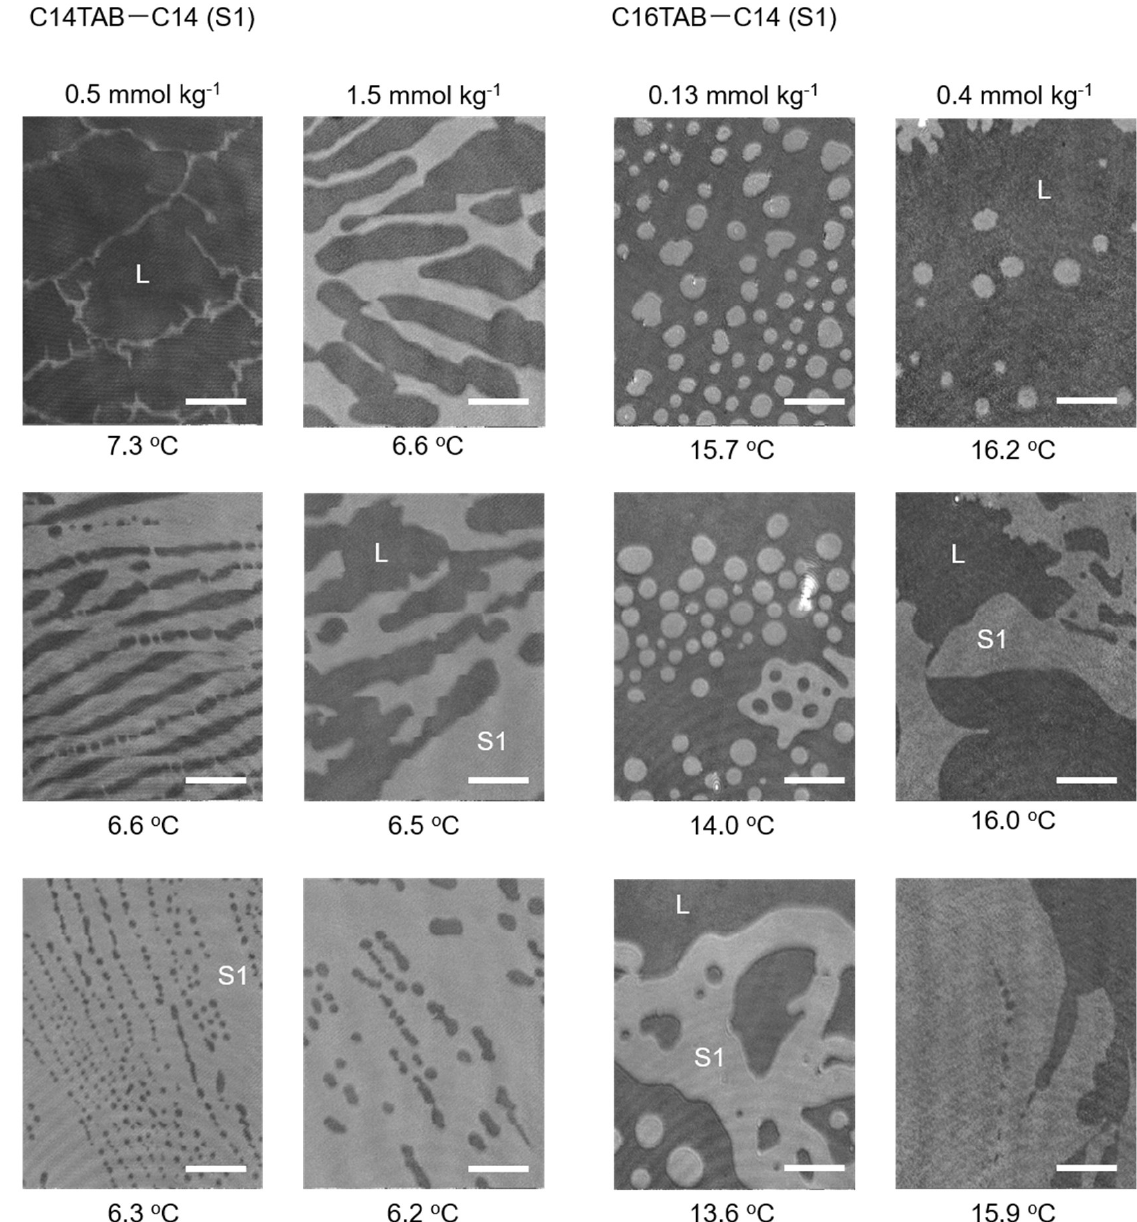
Figure 3. BAM images of nucleated S1 domains for the C14TAB − C14 system (left two columns) and those for the C16TAB − C14 system (right two columns). Images for the C14TAB − C14 system at 0.5 mmol kg − 1 were adapted with permission from Ref. [22] (H. Matsubara et. al, J. Phys. Chem. Lett . 2013 , 4 , 844–848. Copyright 2013 American Chemical Society).